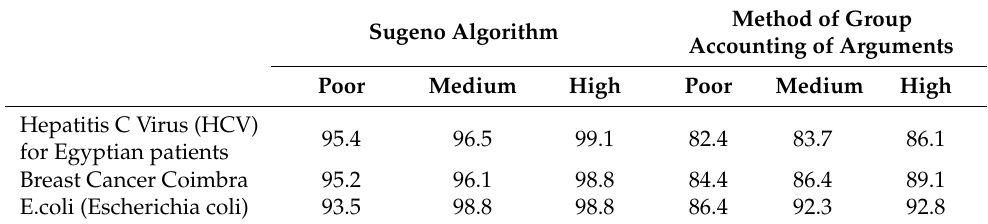
Table 3. Comparative analysis of the proposed model with other databases.